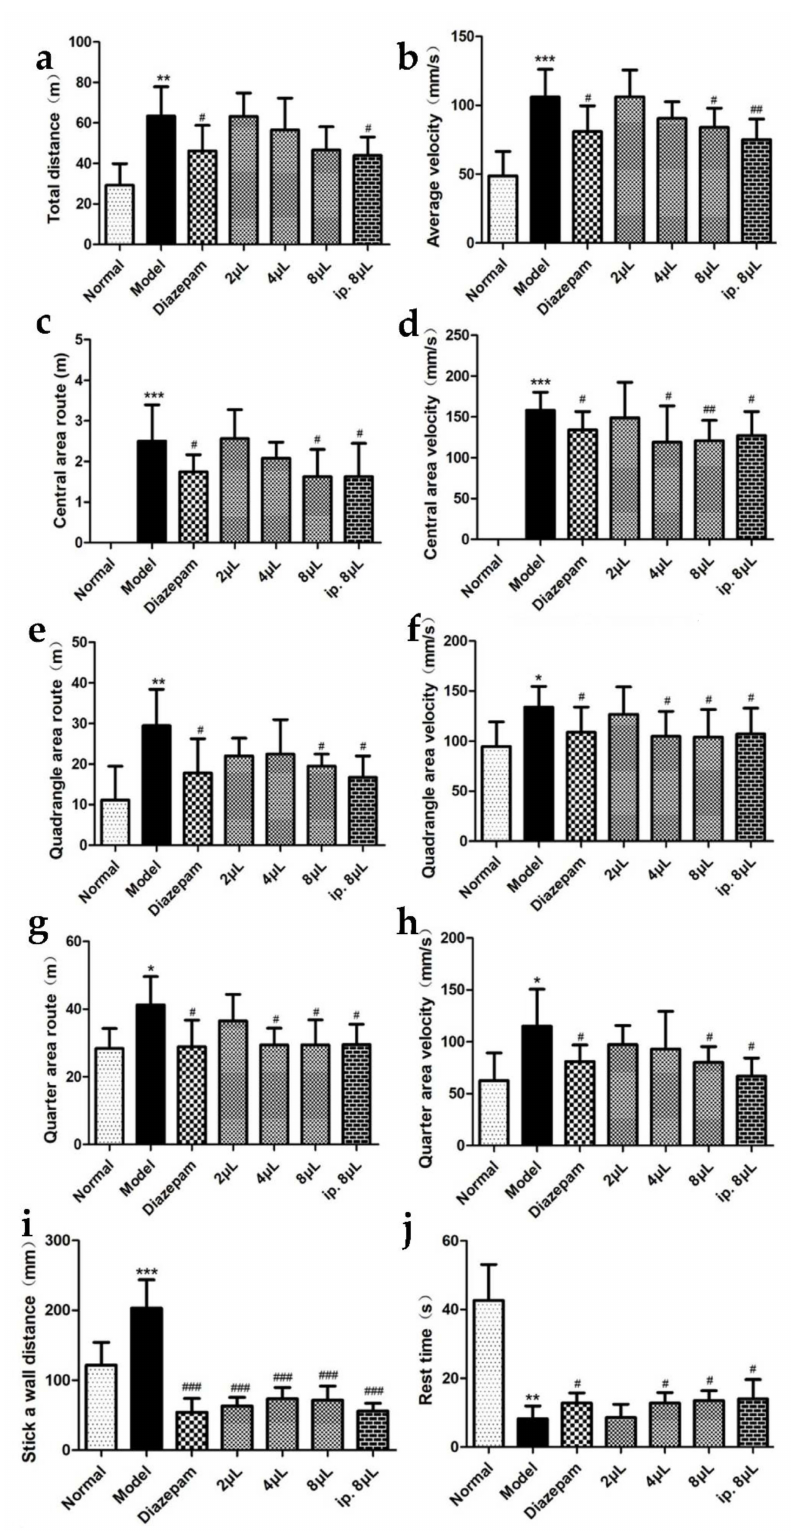
Figure 2. Effects on autonomous activities of AEO inhalation. ( a ) Total distance, ( b ) average velocity, ( c ) central area route, ( d ) central area velocity, ( e ) quadrangle area route, ( f ) quadrangle area velocity, ( g ) quarter area route, ( h ) quarter area velocity, ( i ) stick a wall distance, ( j ) rest time. All values are expressed as the means ± SD ( n = 8). * p < 0.05, ** p < 0.01, *** p < 0.001 vs. normal group; # p < 0.05, ## p < 0.01, ### p < 0.001 vs. model